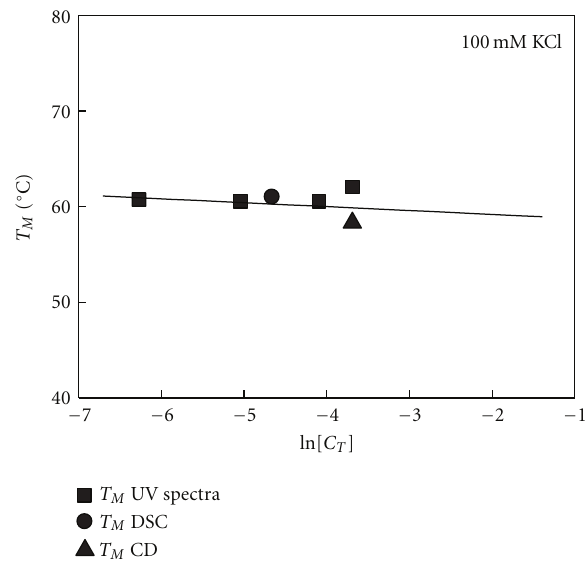
Figure 2: Melting temperature dependence on concentration of oligonucleotide. A linear dependence of T M with strand concentra- tion demonstrates that the G-quadruplex formed is intramolecular. Filled squares are T M from UV melting curves, filled circle is T M from DSC and filled triangle is T M from CD.